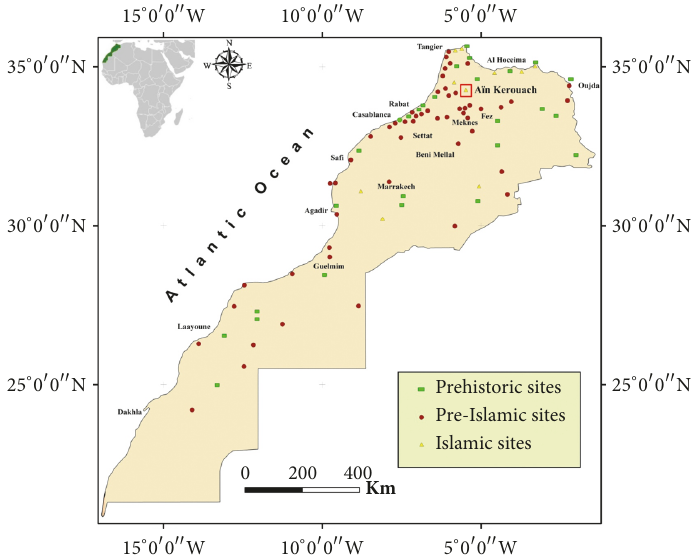
Figure 1: Main Moroccan archaeological sites. The site of A¨ın Kerouach is highlighted with red rectangle [13].